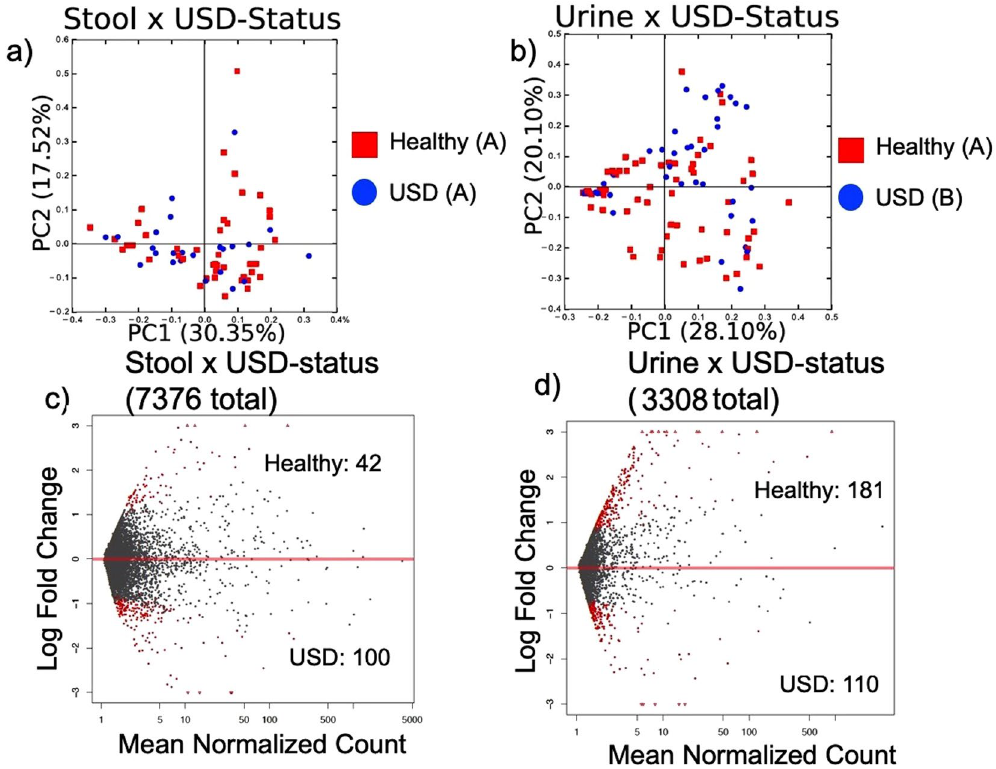
Figure 3. Microbiome analysis by USD-status. ( a , b ) PCoA plots based on a weighted UniFrac analysis by USD- status, with each principal component listed with % of the dissimilarity explained by the coordinate. Statistical significance was determined by an ANOSIM with 999 permutations. Letters denote differences with p < 0.05. ( c , d ) The differential abundance of OTUs by USD status as assessed by a negative binomial Wald test. Red dots indicate significantly different OTUs (FDR < 0.05), gray dots indicate non-significant OTUs. Listed are the total number of OTUs defined within the group, along with the number of OTUs enriched in each specimen type by group.